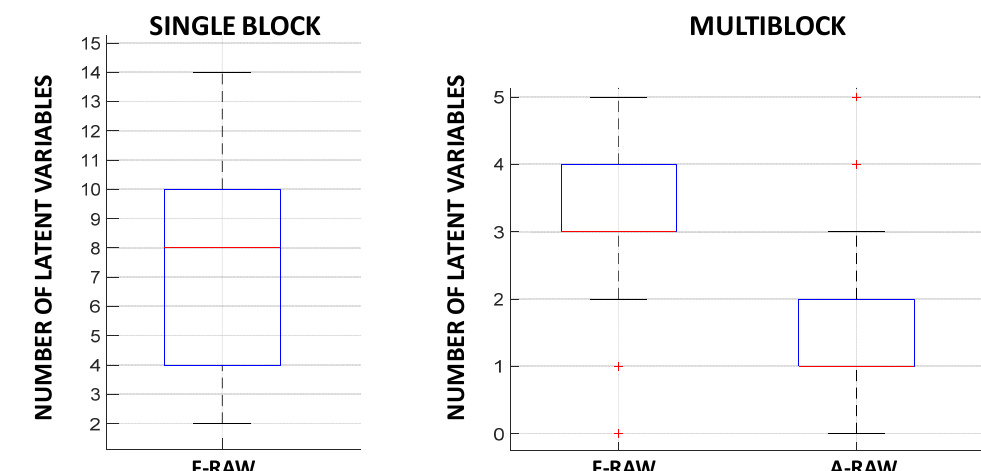
Figure 5. RMSEP boxplots of 50 iterations of the double cross-validation for models including pre- treated data. Bottom and top edges of the blue box are the 25th and 75th percentiles, respectively; the central mark is the median; whiskers extend to the most extreme data points not considered outliers; the ‘+’ symbol plots outliers.